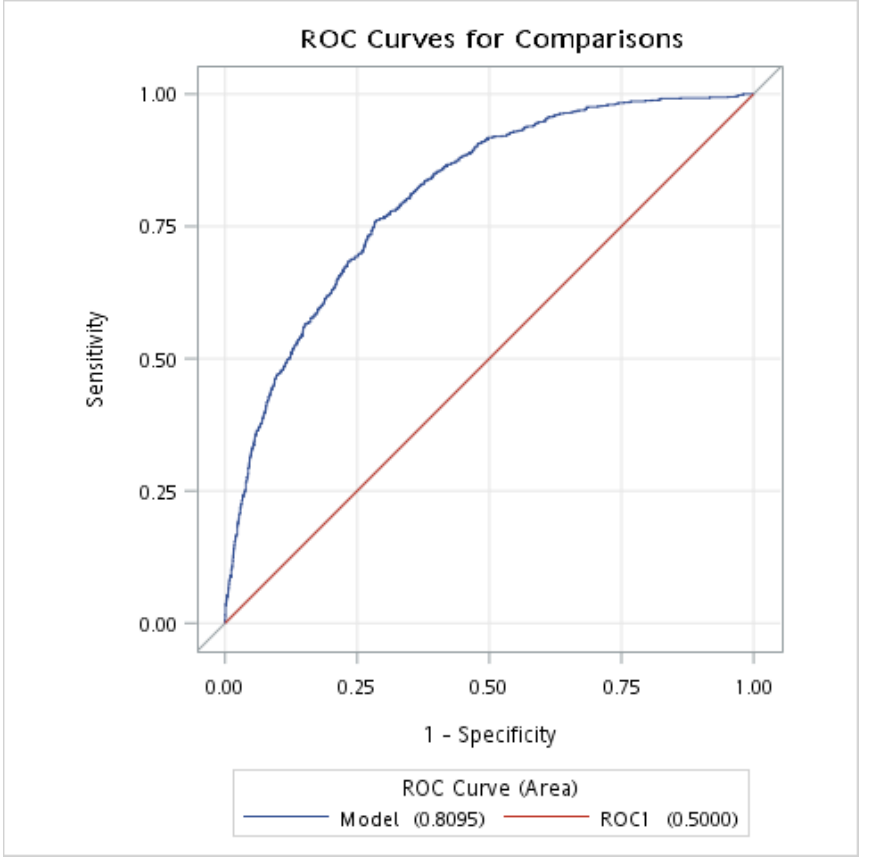
Figure 2. The AUROC of NPAR for NAFLD in individuals without DM. AUROC, area under the receiver operating characteristic curve; DM, diabetes mellitus; NAFLD, nonalcoholic fatty liver dis- ease; NPAR, neutrophil-percentage-to-albumin ratio. This analysis was adjusted for age (continuous), gender, race, BMI, smoking, hypertension, and history of CVD.